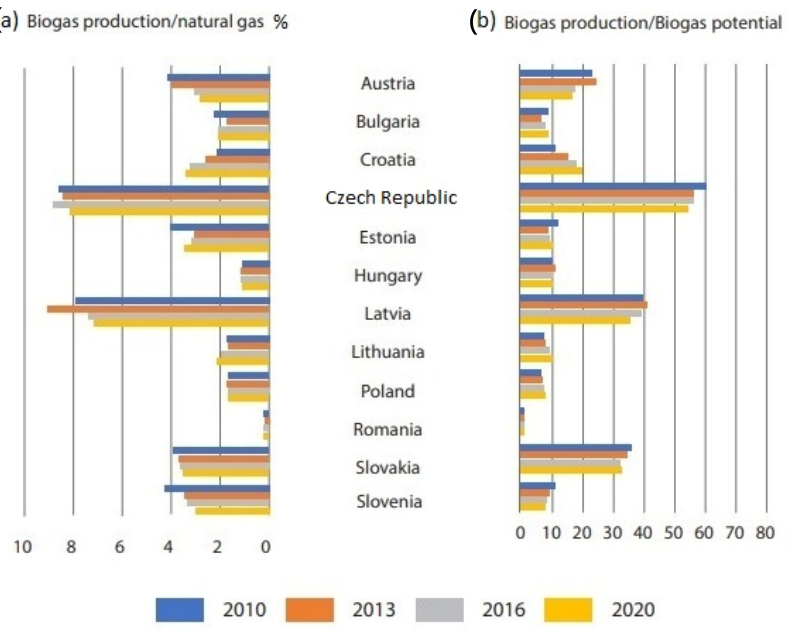
Figure 4. Biogas production against natural gas consumption ( a ) and biogas potential ( b ).